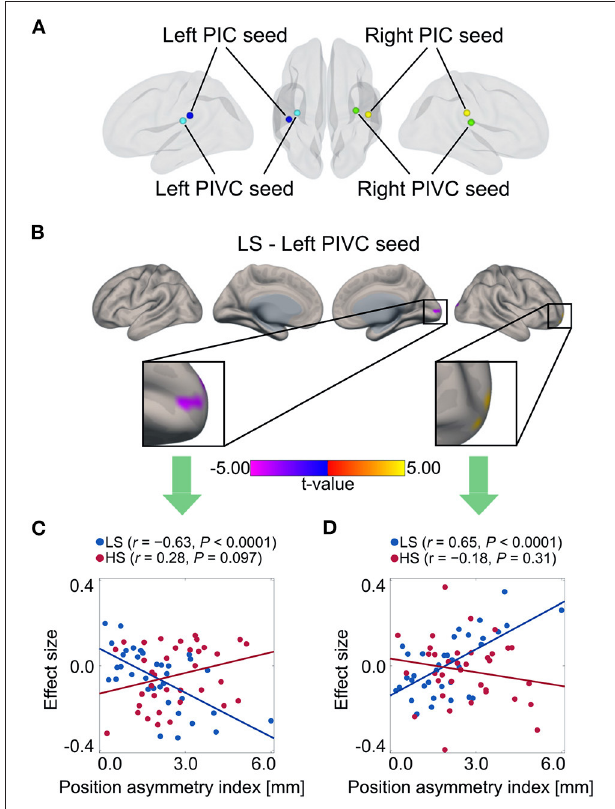
FIGURE 5 | Correlation between position asymmetry index and functional connectivity of cortical vestibular networks in each group. (A) Vestibular seed regions used in seed-based resting-state functional connectivity analysis. Correlations in left PIVC seeds were found only in LS group. (B) Negative correlation between position asymmetry index and functional connectivity between left PIVC and medial occipital cortex in the LS group. Positive correlation between position asymmetry index and functional connectivity between left PIVC and right lateral frontal pole in the LS group. (C) Scatter plot of position asymmetry index and functional connectivity between the left PIVC and medial occipital cortex in each group. There was a negative correlation in the LS group, but not in the HS group. (D) Scatter plot of position asymmetry index and functional connectivity between the left PIVC and the right lateral frontal pole in each group. There was a positive correlation in the LS group, but not in the HS group. PIC, parietoinsular